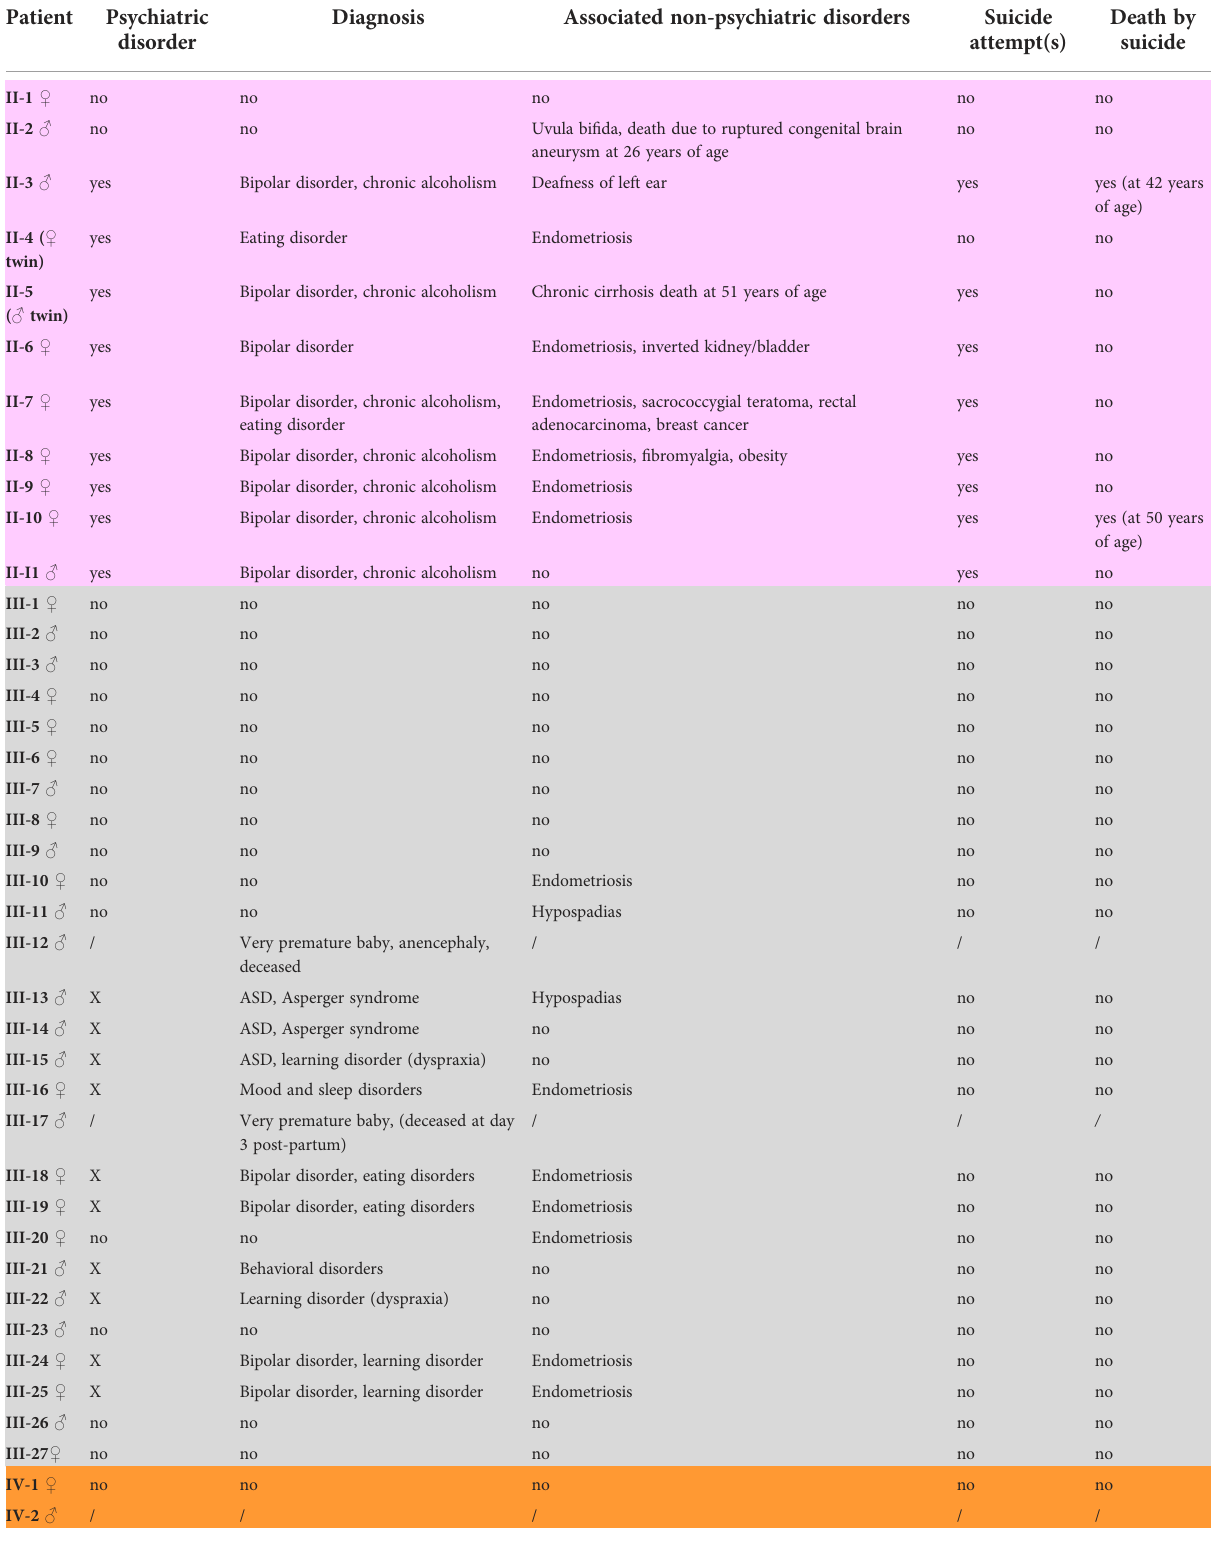
TABLE 3 Psychiatric disorders (columns 2 and 3) and comorbidities (column 4) in the four generations of an informative family (column 1) whose mother ( fi rst generation) took DES for 3 months after each delivery (see Figure 2 ).